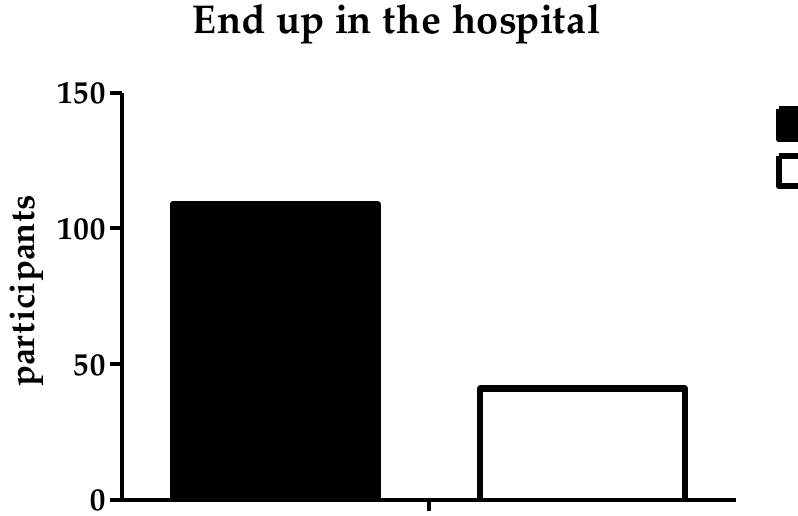
Figure 10. Number of participants who ended up in hospital. The effects of alcohol consumption were reported by the participants, with the excep- tion of 12 participants who experienced no ill effects. These effects were related to their social, personal, and psychological lives and their health. The majority shared that their general and mental health had deteriorated, while a few reported that they had lost their jobs and their family